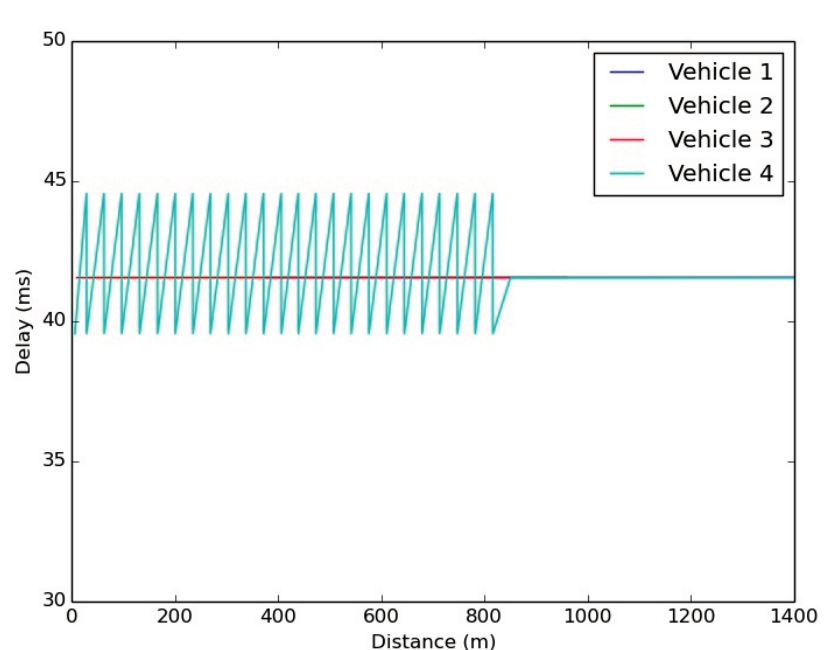
Figure 3. Vehicle reception